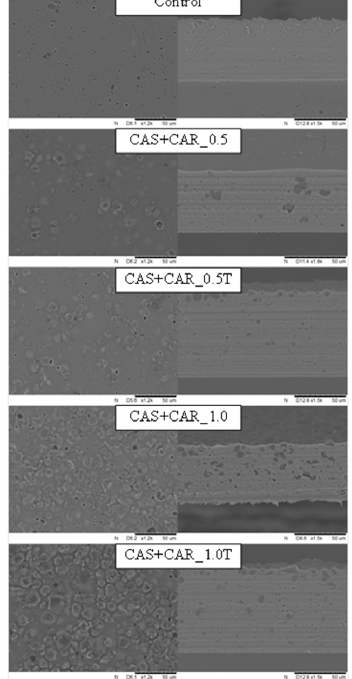
Figure 4. Scanning electron micrographs of surfaces (×1500) and cross-sections (×1800) of sodium caseinate films without and with carnauba wax at 0.5 and 1.0%. Abbreviations: CAS—sodium caseinate, CAR—carnauba wax, T—Tween-80.